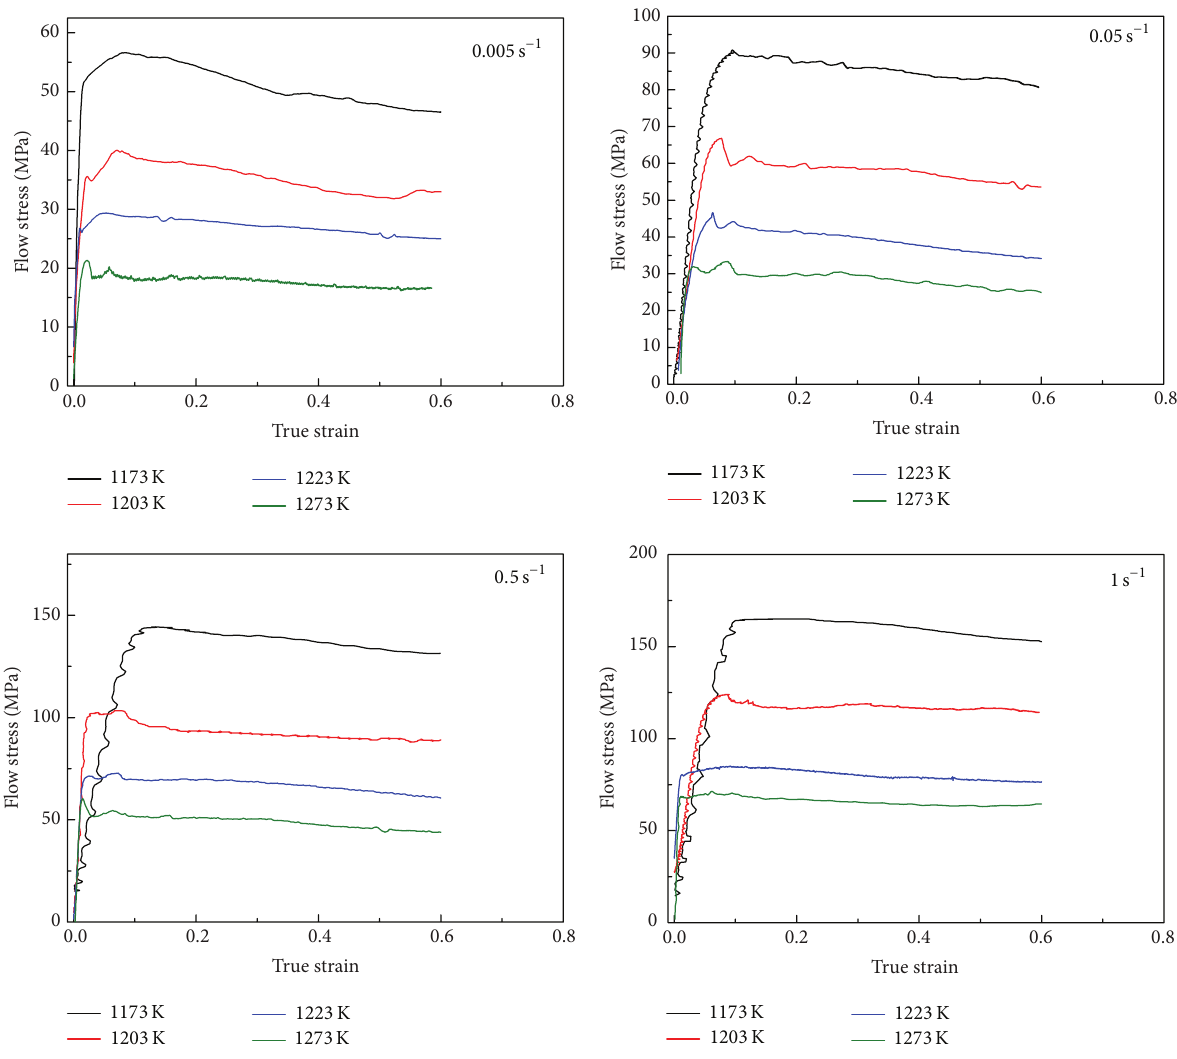
Figure 2: The true stress-strain curves of TA15 titanium alloy at different strain rates.